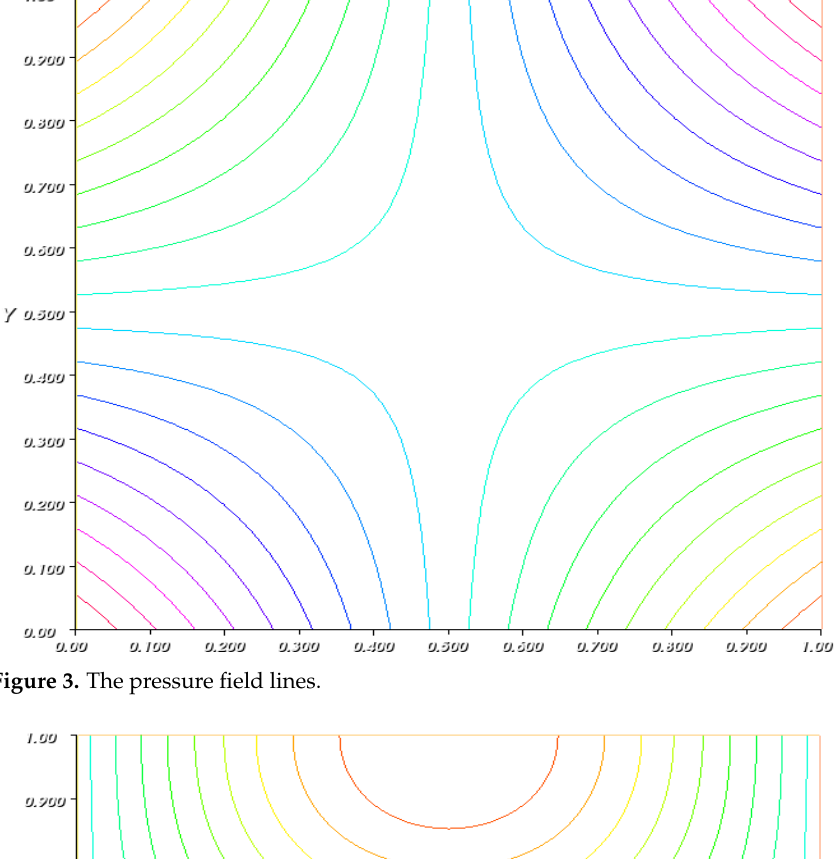
Figure 3. The pressure field lines.